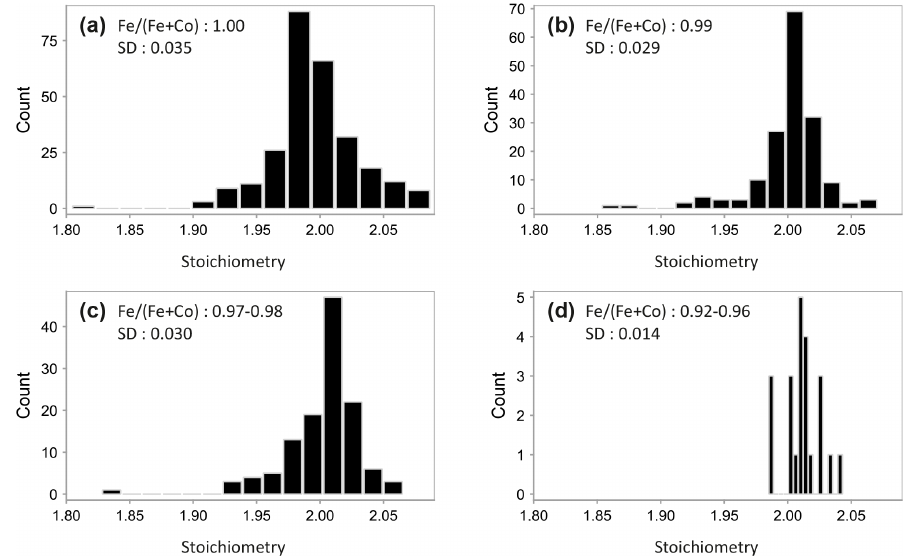
Figure 3. Stoichiometry distributions in four groups of pyrite with differing Co